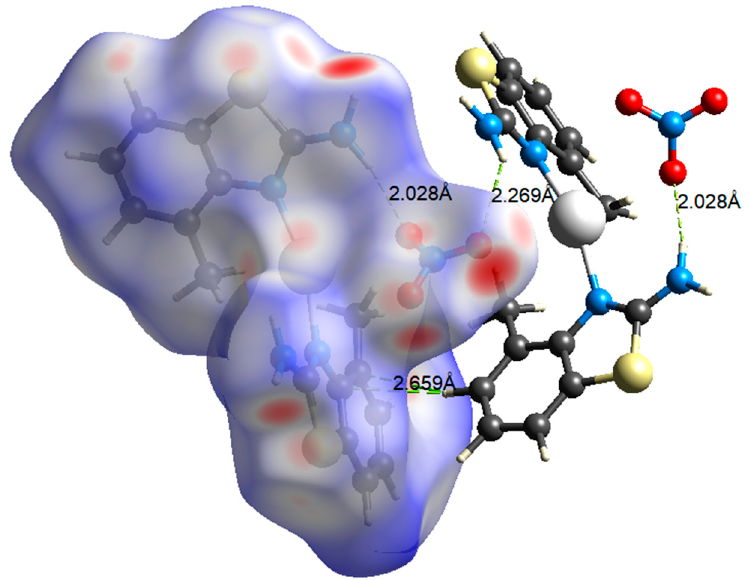
Figure 2. An overview of 3D Hirshfeld surface of complex 2 , plo tt ed over d norm in the range of − 0.4462 to 1.3360. Light green do tt ed lines signify prominent hydrogen bonds. Table 3. Summarized structural parameters, bond angles (°) and bond lengths (Å) for compounds 2 and 4 .